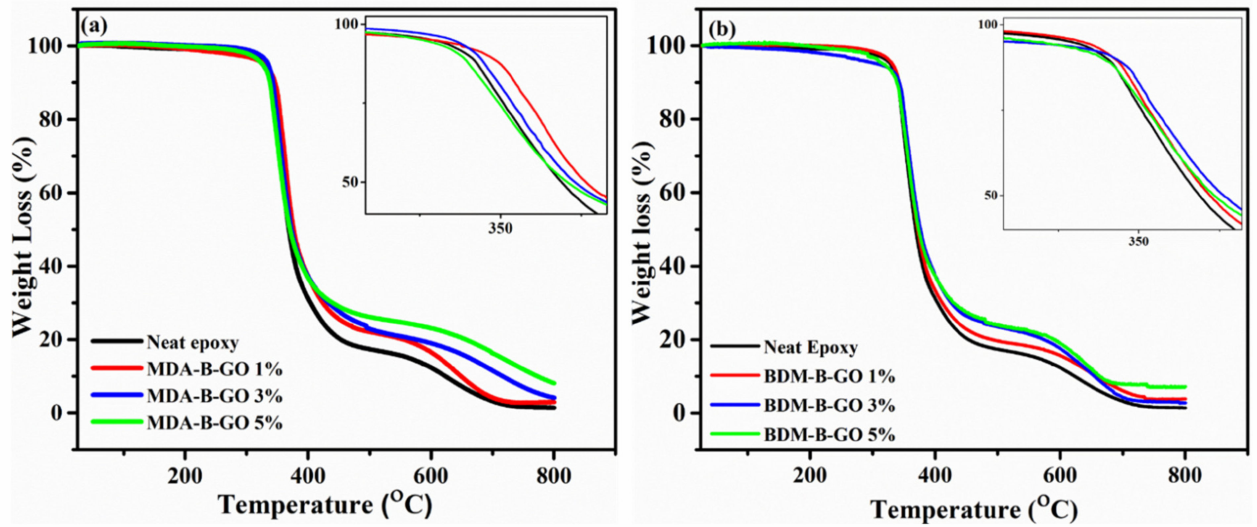
Figure 8. TGA thermograms of ( a ) Neat epoxy and its MDA-B-GO nanocomposites ( b ) BDM-B-GO